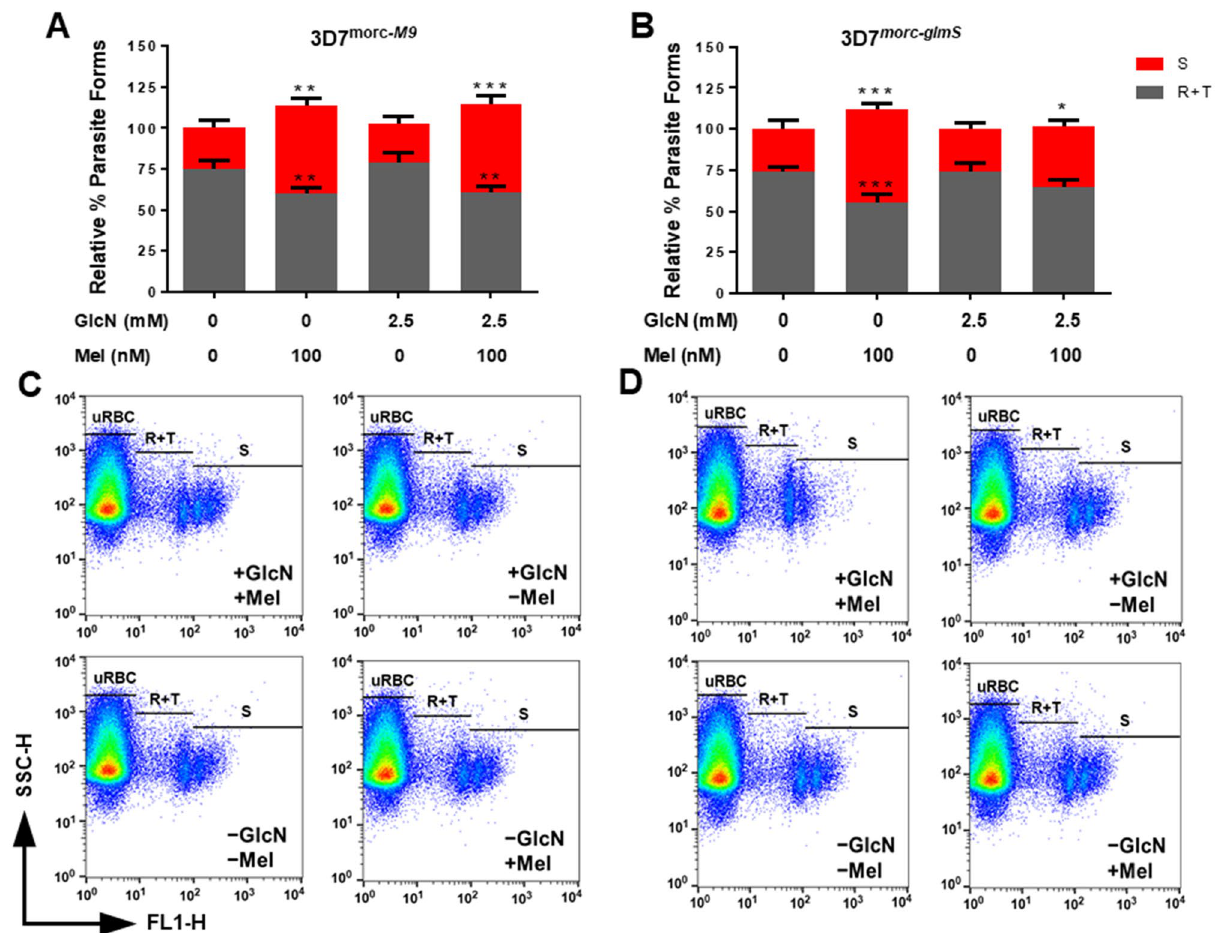
Figure 5. Effect of melatonin after knocking down PfMORC protein expression. Asynchronous parasites were first treated with or without 2.5 mM glucosamine for 48 h and then incubated with and without melatonin (100 nM) for 24 h. The parasites were stained with nuclear dye YOYO-1 and passed through the flow cytometer. R + T and S forms of the parasite population were calculated and plotted the percent population for both 3D7 morc-M9 and 3D7 morc-glmS . ( A ) Absence of melatonin shows high mono nucleated R + T form but 100 nM melatonin treatment increases the mature stage parasites in 3D7 morc-M9 irrespective of glucosamine treatment; ( B ) but the effect of melatonin was partly interrupted to increase the S form 3D7 morc-glmS , which is sensitive to glucosamine treatment, albeit R + T remained relatively similar to control. ( C , D ) and ( E , F ) represent the dot plot representation for melatonin effect with and without glucosamine for 3D7 morc-M9 and 3D7 morc-glmS , respectively. Each graphics represents the three independent experiments in triplicate for mean ± SD and the statistical difference was obtained by one-way ANOVA using Dunn’s multiple comparison test. *> 0.05, **> 0.01, ***>